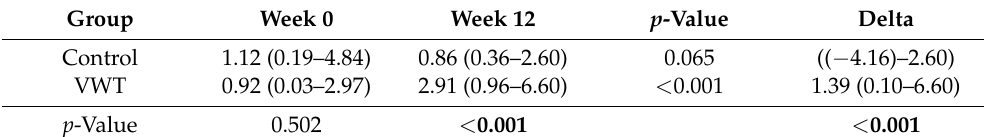
Table 5. Differences in NO levels between and within groups, before and after the